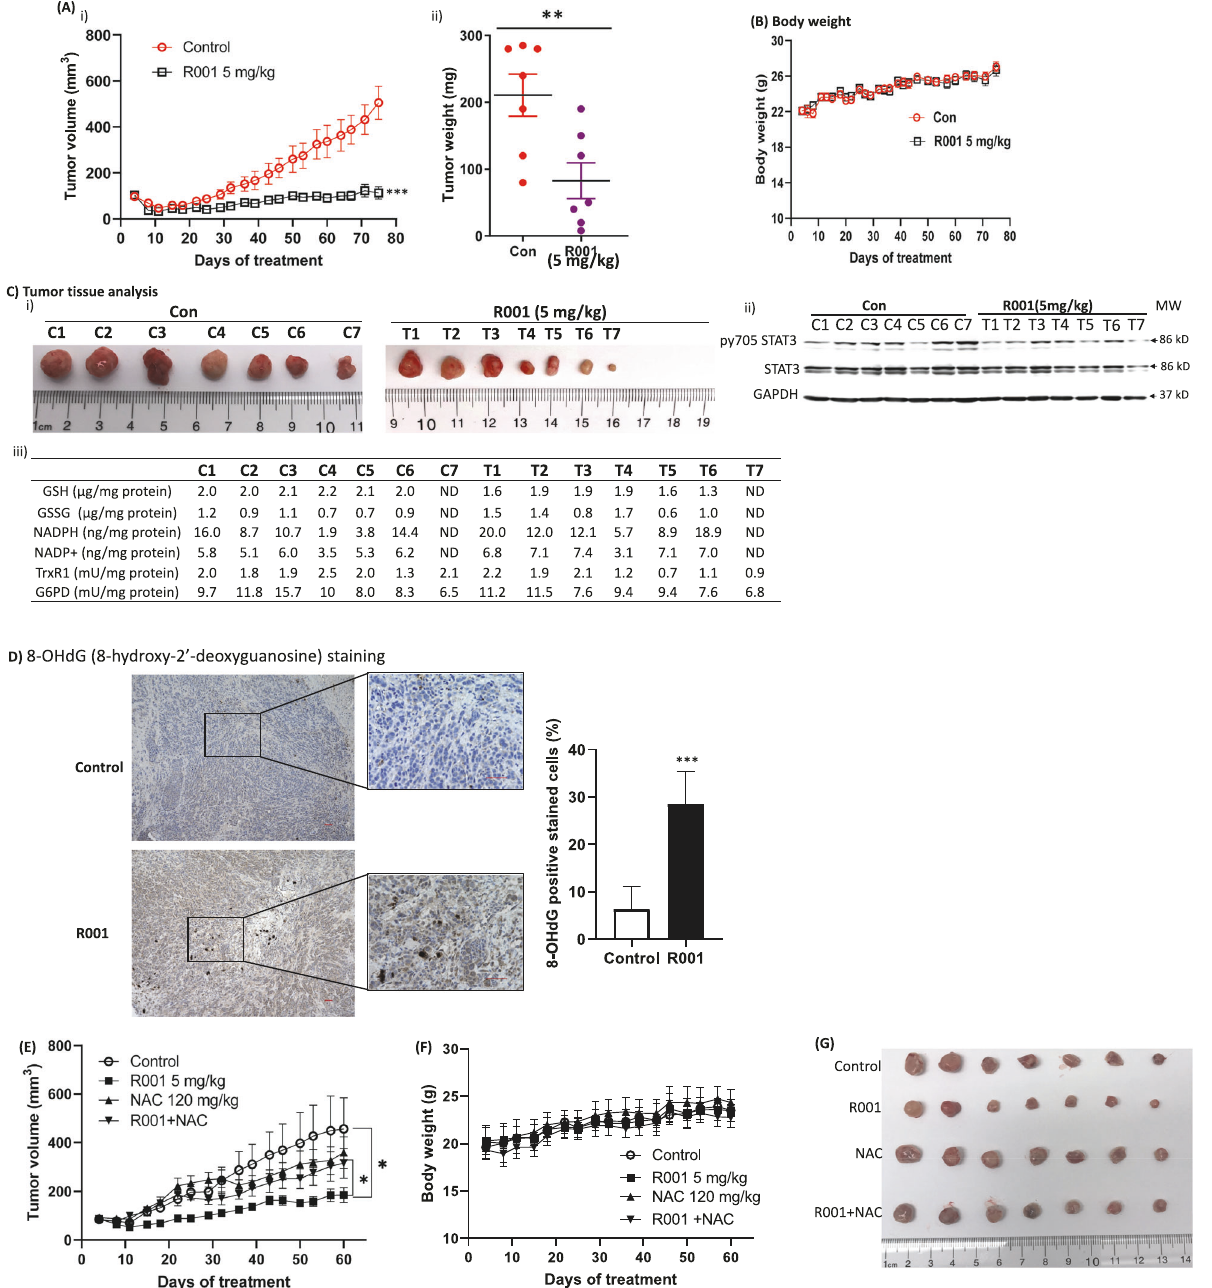
Fig. 6 Antitumor effects of R001 against human breast tumor xenografts in vivo. A Mice bearing MDA-MB-468 subcutaneous tumor xenografts were administered 5 mg/kg R001 via oral gavage, or vehicle (5% DMSO in PBS) every day, 5 days per week for 75 days. Tumor sizes, measured every 3 – 4 days, were converted to (A)(i) tumor volumes and plotted against days of treatment, or (ii) tumors were excised at the end of study and weighed and plotted; B plot of body weight of tumor-bearing mice versus day of treatment; and C control (C1 – C7) or residual treated (T1 – T7) tumor tissues at the end of study which were imaged and shown (i), or were used to prepare lysates and each subjected to immunoblotting analysis probing for pY705 STAT3, STAT3, and GAPDH (ii), or analyzed for GSH, GSSG, NADPH, and NADP + levels, or TrxR1 and G6PD activities (iii); D images (Left panel) of 8-hydroxy-2 ′ -deoxyguanosine (8-OHdG) immunohistochemical staining of tumor tissues from control and R001-treated mice, and a plot of the quanti fi cation of three different visual fi elds of the same slide (right panel); data representative of 3 mice; scale bar = 50 µm; and E – G mice bearing MDA-MB-468 subcutaneous tumor xenografts were administered 5 mg/kg R001 alone or 120 mg/kg NAC alone via oral gavage, R001 and NAC combined, or vehicle (5% DMSO in PBS) every day, 5 days per week for 60 days. Tumor sizes were measured every 3 – 4 days, converted to tumor volumes and E plotted against days of treatment, or F plot of body weight of tumor-bearing mice versus day of treatment; and G tumors were excised at the end of study and imaged. Control (Con) represent mice treated with vehicle, 5% DMSO in PBS. Values, mean ± S.E.M., n = 7. * p < 0.05, ** p < 0.01, and *** p < 0.001; ND not determined, MW molecular weight.